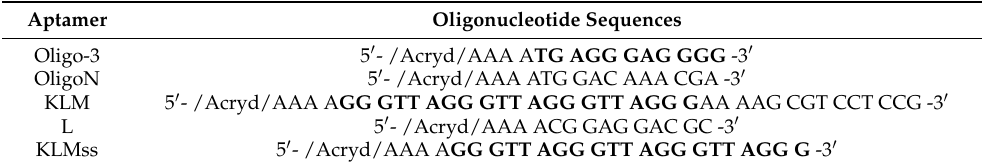
Table 1. DNA oligonucleotide sequences used for sensors fabrication. Parts of the sequences with aptamer functionality are indicated by bold